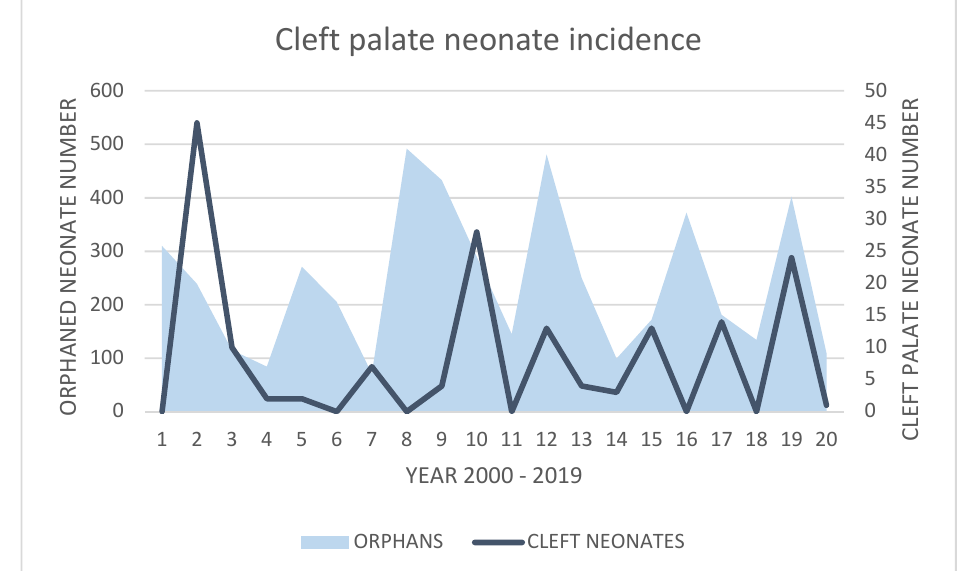
Figure 6 . Cleft-palate-syndrome-affected neonates versus total deceased and orphaned neonates by year of birthing season (October–December).